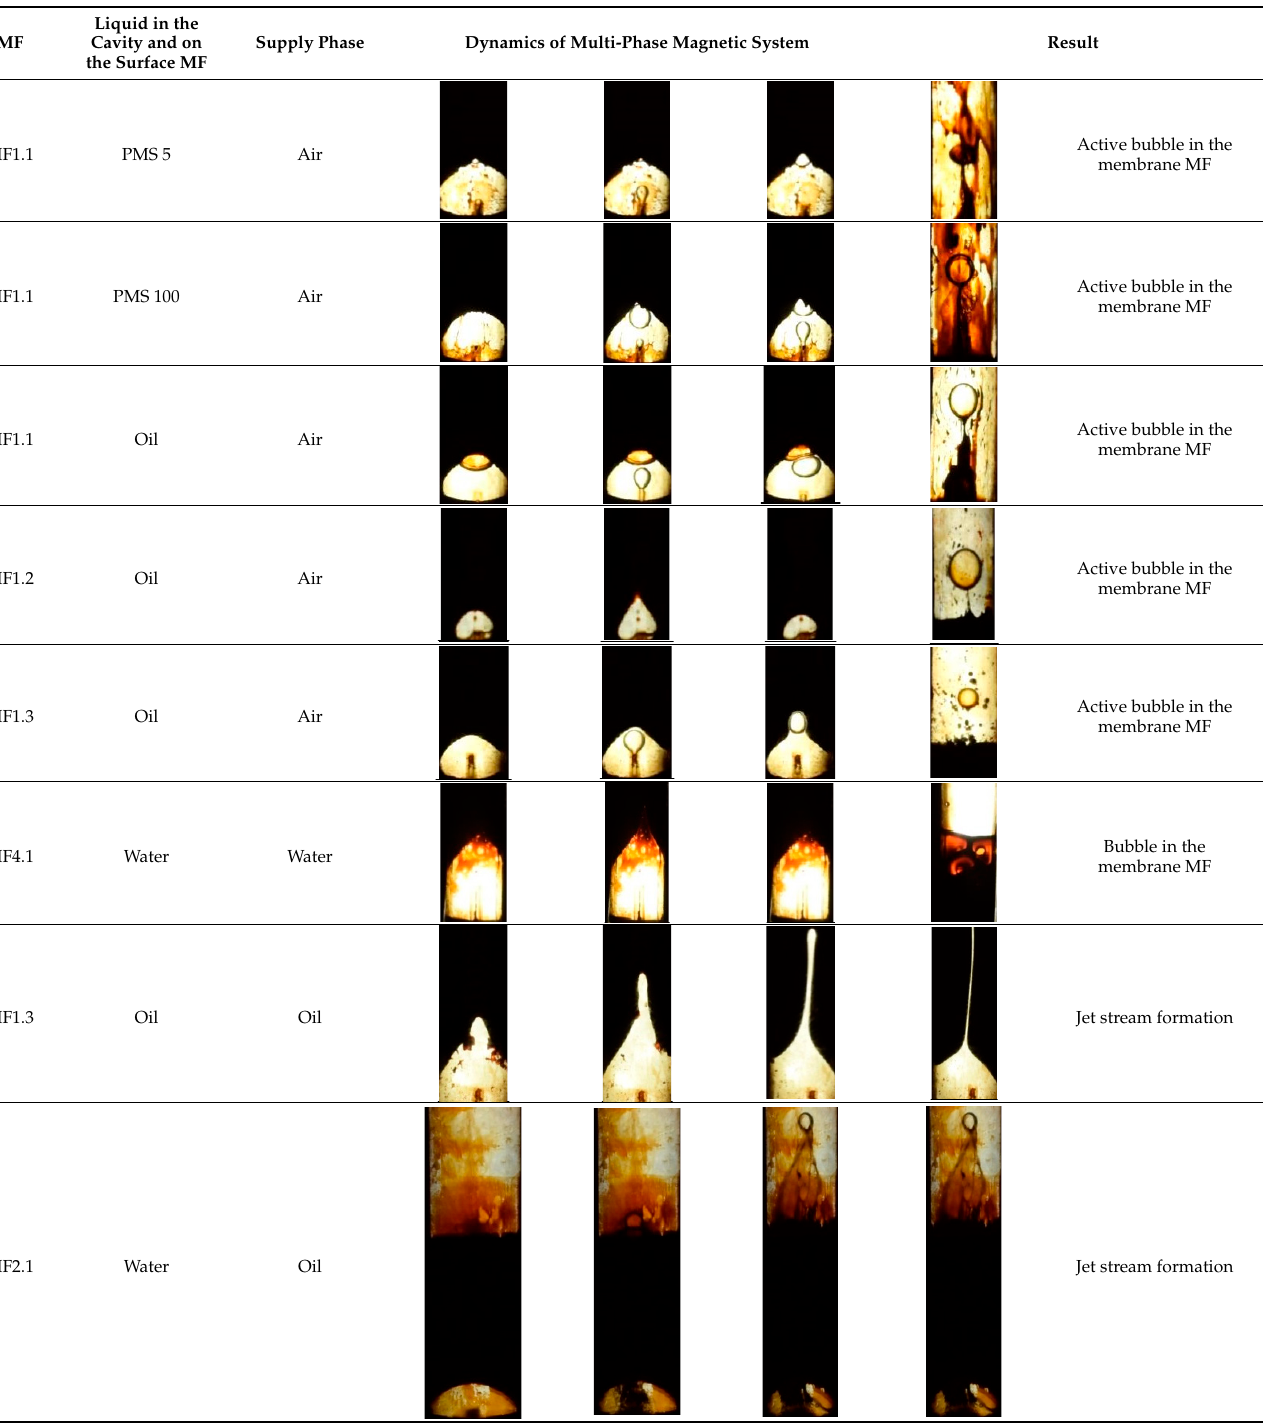
Table 4. Results of Experiment No.2.